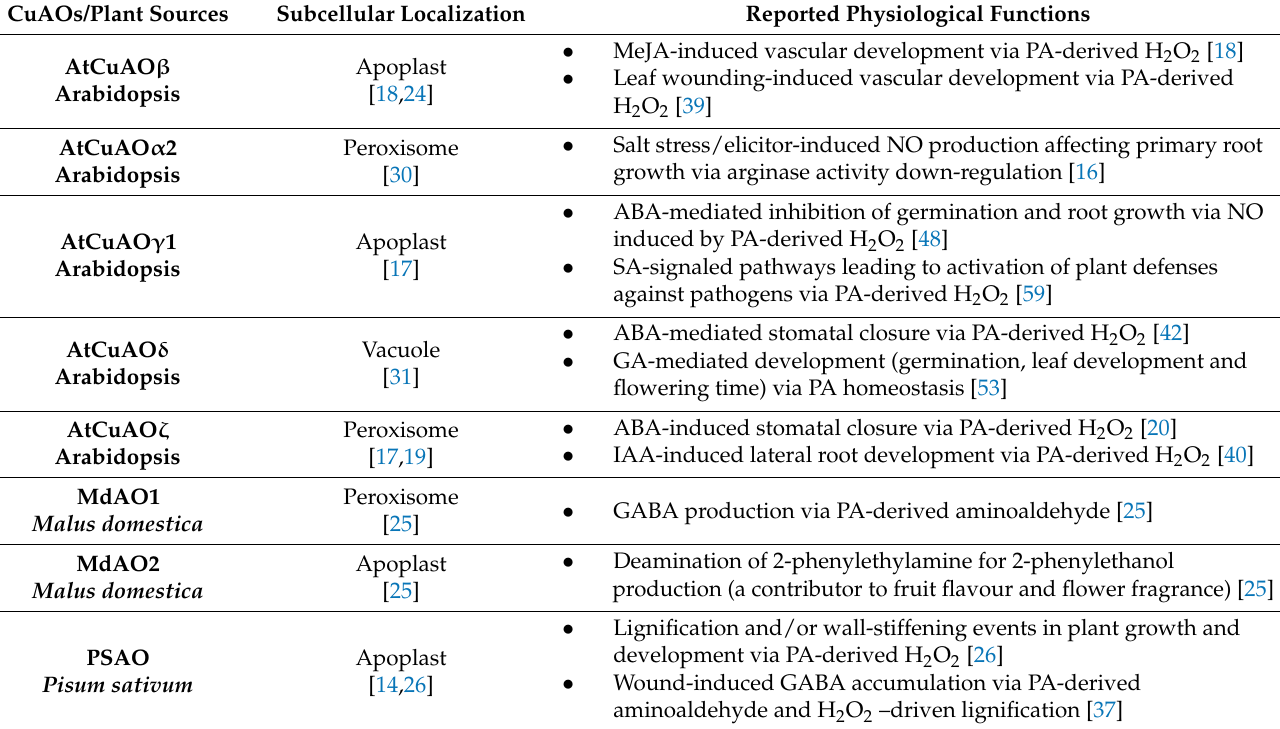
Table 1. Subcellular localization and physiological functions of plant